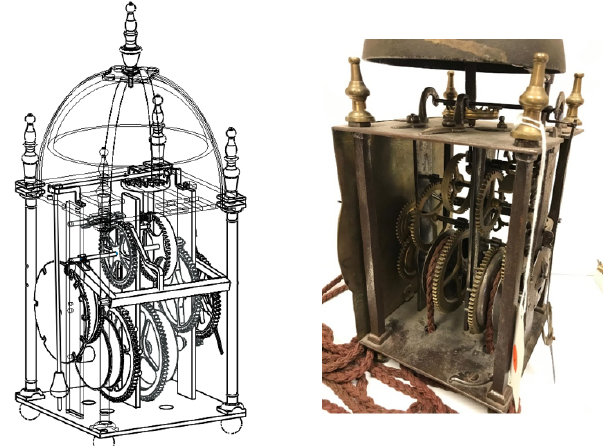
Figure 30. N12 – Italian lantern clock (Bonhams, 2022a).